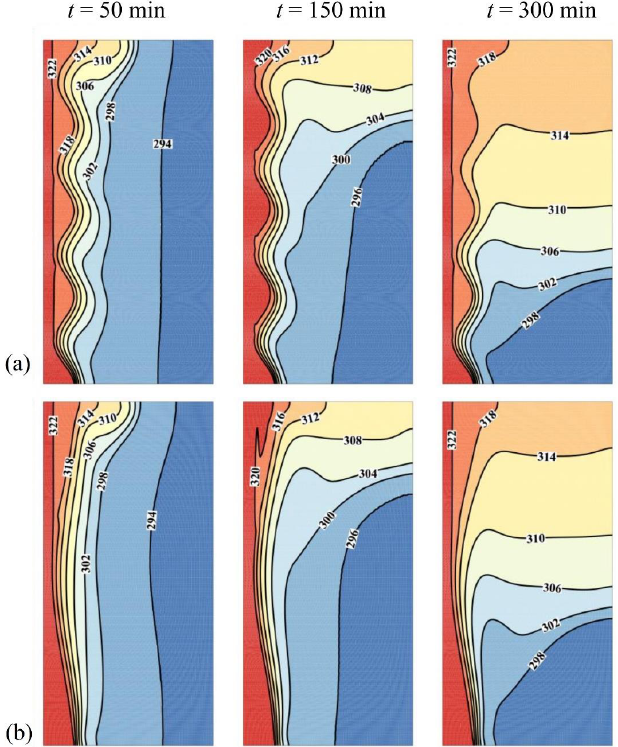
Figure 11. Effect of number of waves ( N ) on the contours of isotherms, ( a ) Case 6 with N = 4 and ω na = 0.06; ( b ) Case 7 with N = 1 and ω na = 0.06. Molecules 2021 , 26 , x